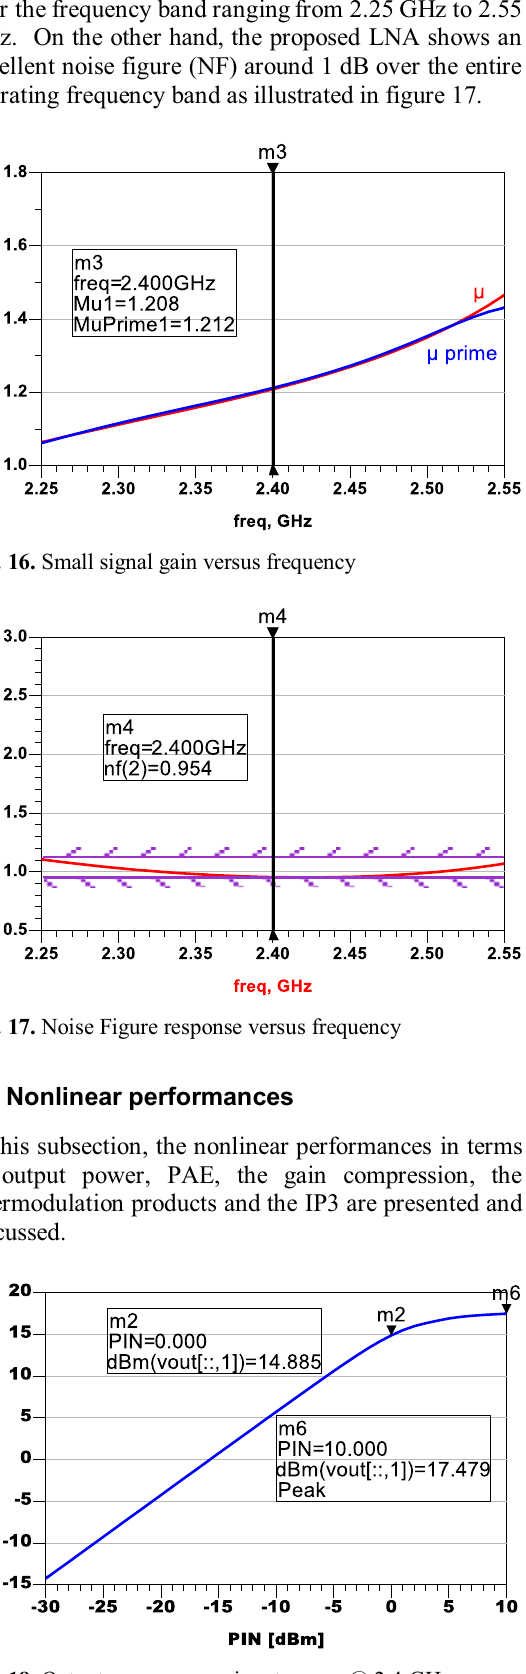
Fig. 18. Output power versus input power @ 2.4 GHz